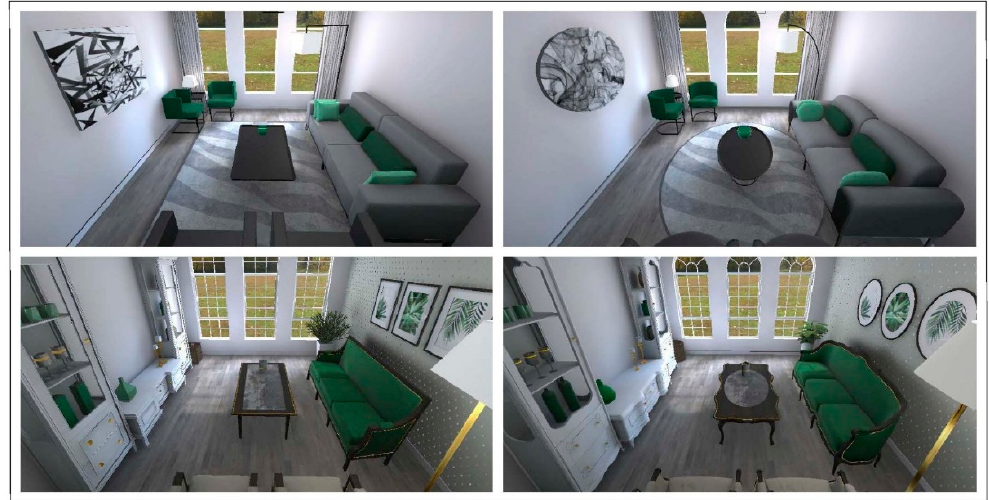
Figure 1. Virtual 3D environments, created for the study. Upper images display the modern style, and the bottom ones the classic style. Top left: angular modern (AM). Top right: curved modern (CM). Bottom left: angular classic (CA). Bottom right: curved classic (CC). Images were taken from the Unity project with a perspective that does not represent a human eye view, to show maximum coverage of the room.